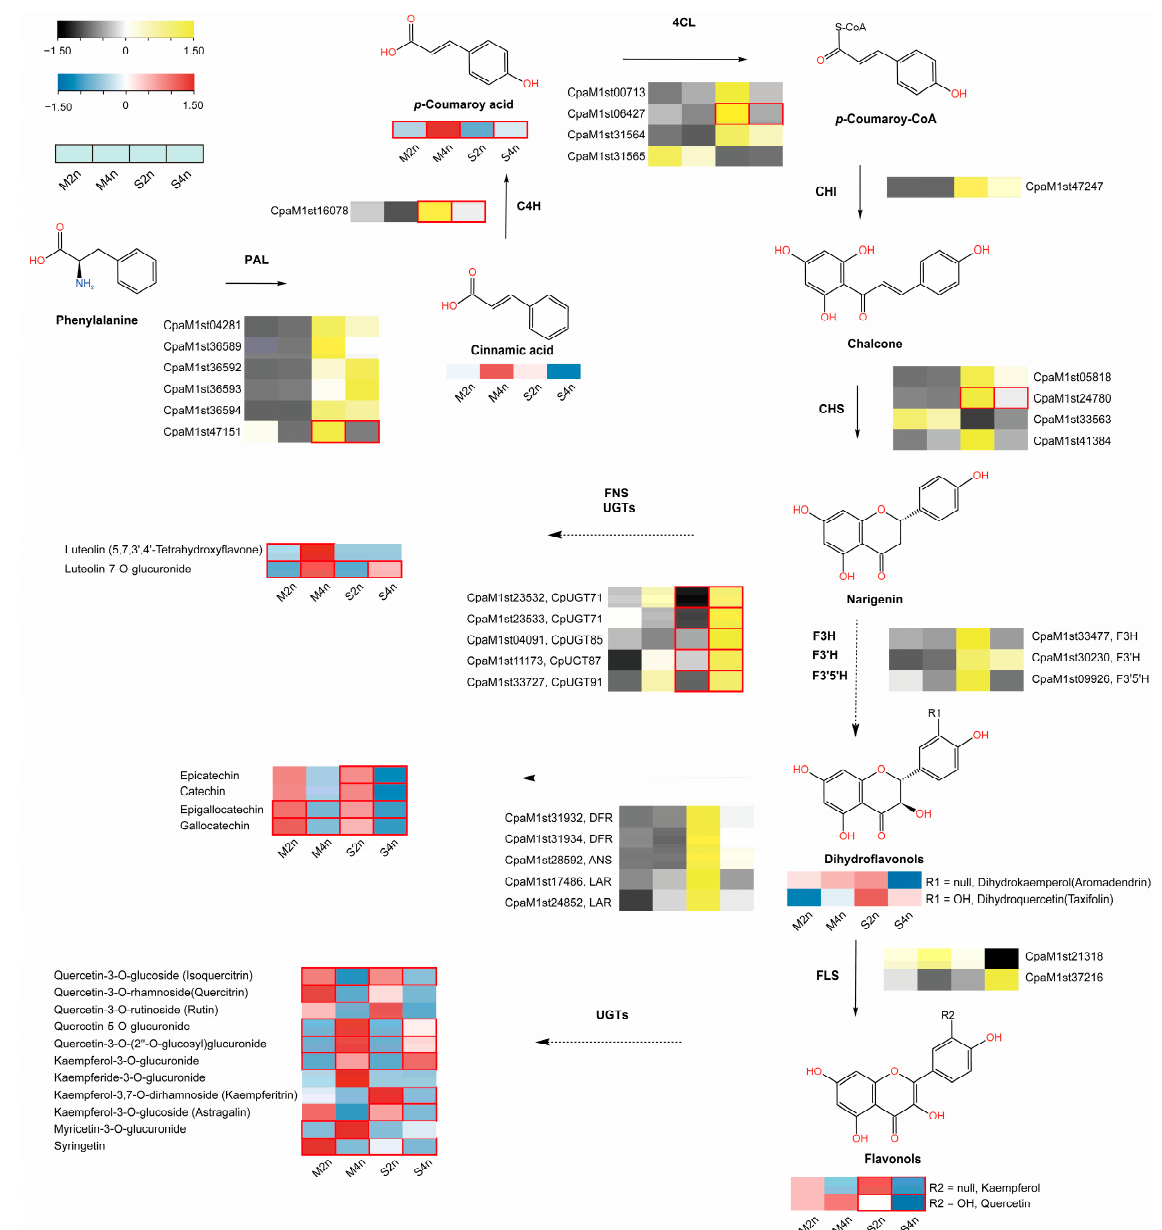
Figure 7. Pathway view heatmap of metabolites and gene expressions in different C. paliurus ploidies. Each sample is represented by a column, and each metabolite/gene is represented by a row. The abundance of each metabolite/gene expression profile is represented by a different color. Red and yellow indicate highly abundant metabolites and high gene expression levels, whereas low-abundant metabolites are presented in blue and low gene expression levels are presented in black, with marked treatments with statistical differences represented by red